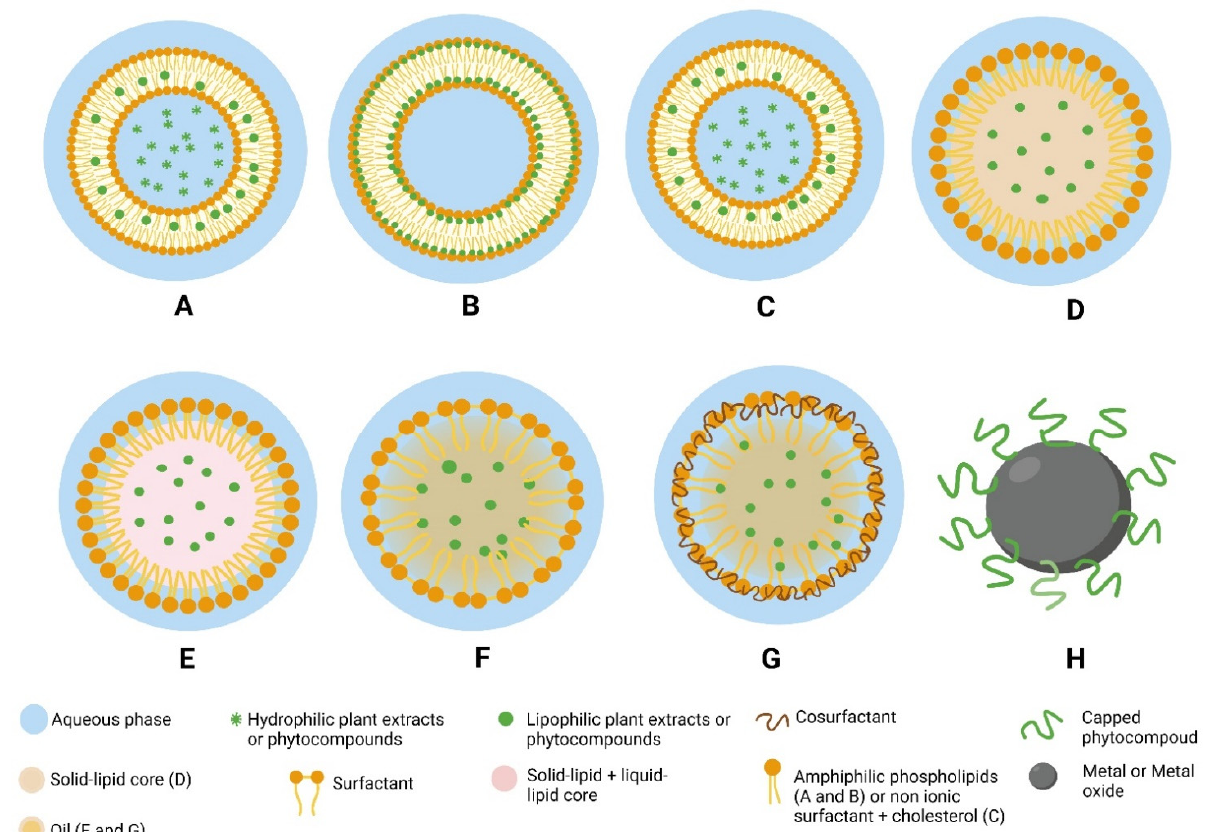
Figure 2. Structures of current lipid- and inorganic-based nanoparticulate delivery systems tested for antidiabetic herbal medicines. ( A ) Liposomes, ( B ) phytosomes, ( C ) niosomes, ( D ) solid lipid nanoparticles, ( E ) nanostructured lipid carriers, ( F ) nanoemulsions, ( G ) self-nanoemulsifying drug delivery systems, and ( H ) green-synthesized metallic or metal oxide nanoparticles. Created with the use of BioRender.com.